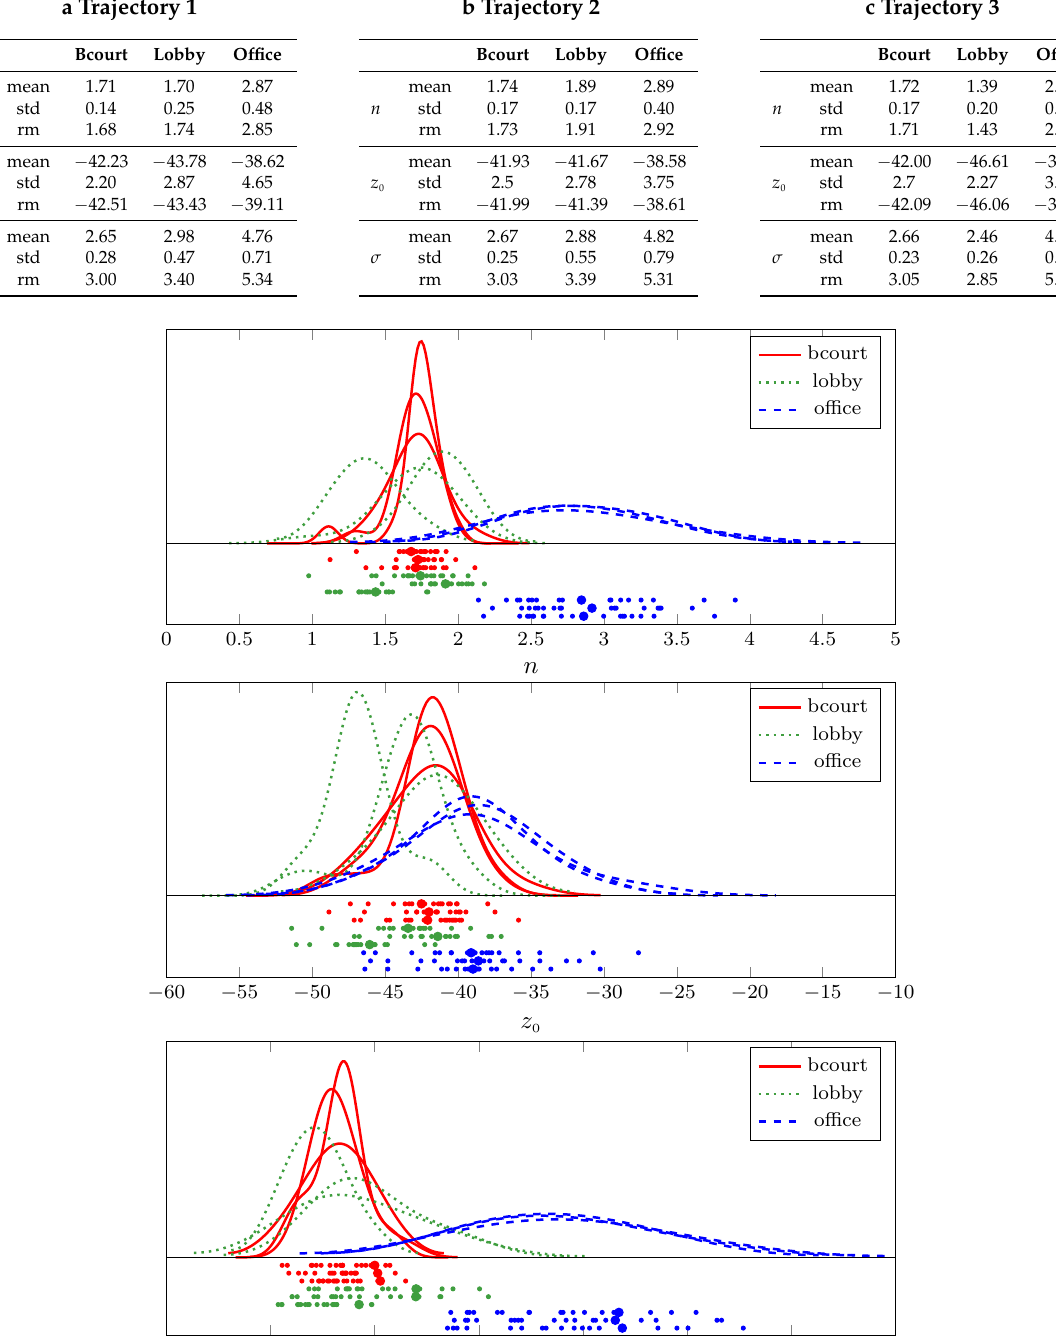
Table 1. Mean and standard deviation of the distributions from Figure 4, and parameters of the reference models (rm).